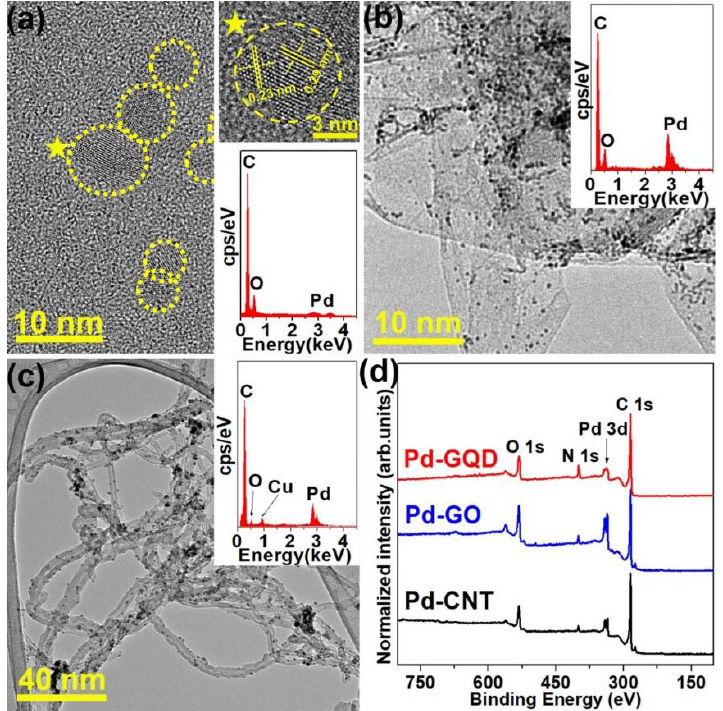
Figure 2. ( a ) TEM image of Pd-GQDs at low magnification. The inset ( top ) shows the enlarged TEM image of the marked area in ( a ). The inset ( bottom ) provides the corresponding EDX spectrum. ( b ) TEM image of Pd-GO with its corresponding EDX spectrum (inset). ( c ) TEM image of Pd-CNT with its corresponding EDX spectrum (inset). ( d ) X-ray photoelectron spectroscopy (XPS) survey results of Pd-GQD, Pd-GO, and